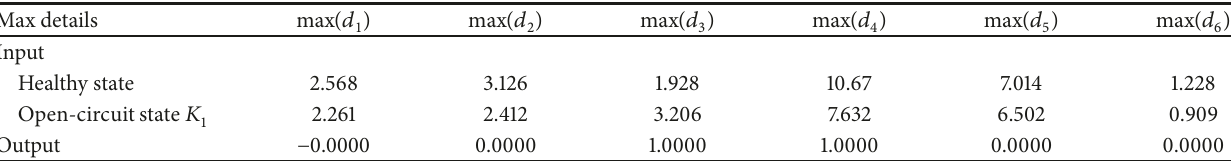
Table 2: Details of one stator current phase for both healthy and faulty open-circuit at 𝐾 1